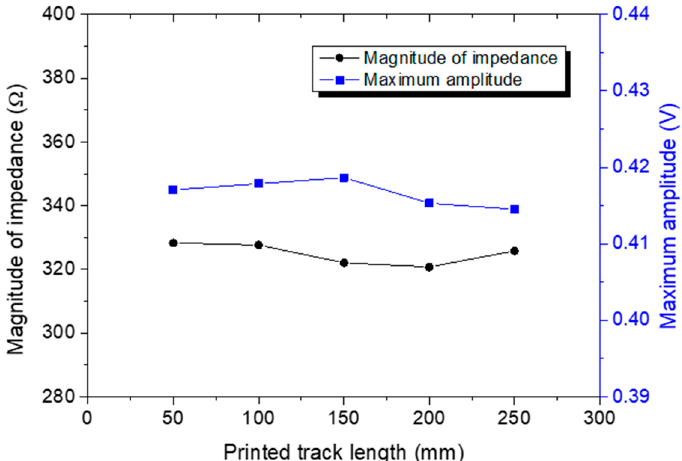
Figure 9. Magnitude of impedance and signal maximum amplitude versus printed wire length.